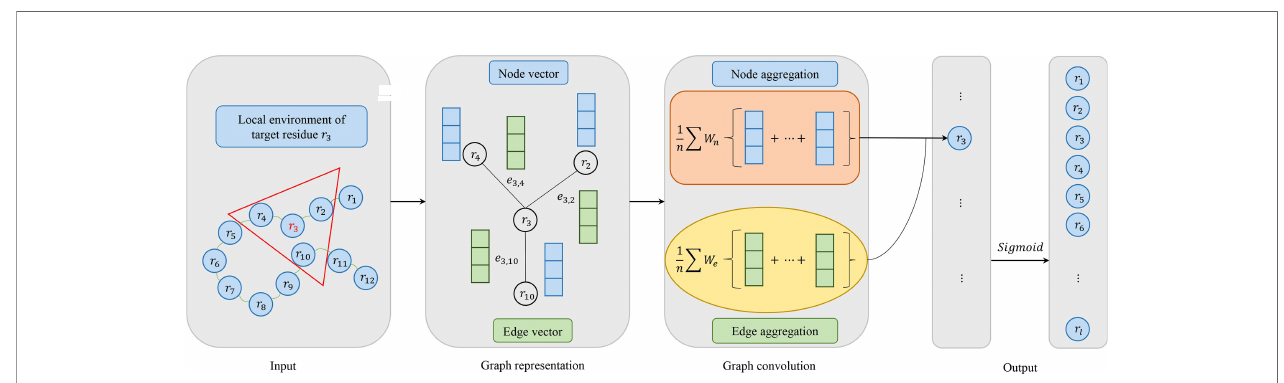
FIGURE 2 | Model architecture of graph convolutional networks consisting of four parts: input, graph representation, graph convolution and output. In the input, the target residue is red and the local environment of the target residue is in a red triangle. For graph representation, node vector is blue and edge vector is green. For graph convolution, if edge vector is used, it corresponds to ^#the formula 4. Otherwise, it corresponds to the formula 3. In the output, we use the Sigmoid activation function.